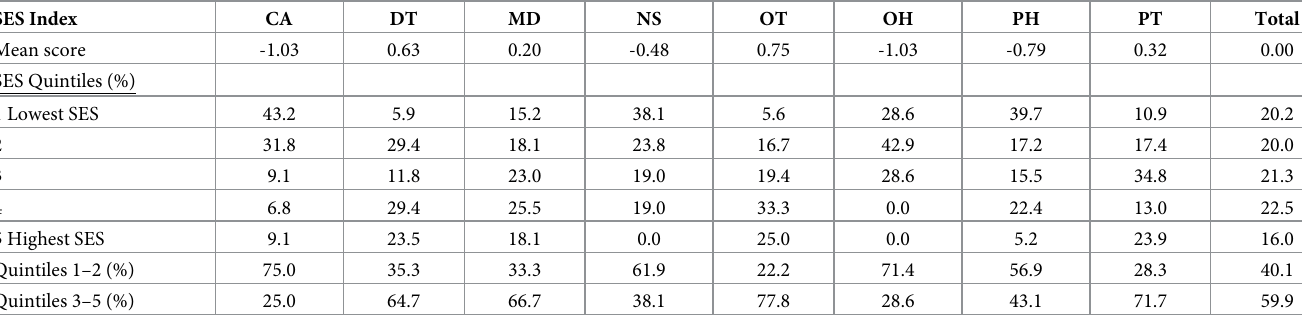
Table 2. Composite socio-economic status of WISDOM cohort members.